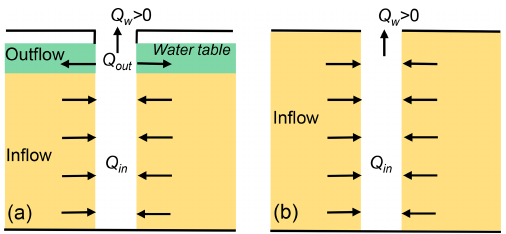
Figure 10. Conceptual cross-sectional views of flow around flow- ing wells. (a) A flowing well with Q in > Q out ; (b) a flowing well with Q in > Q out = 0 (modified from Z. Y. Zhang et al., 2018). Q w means the flow rate at the well